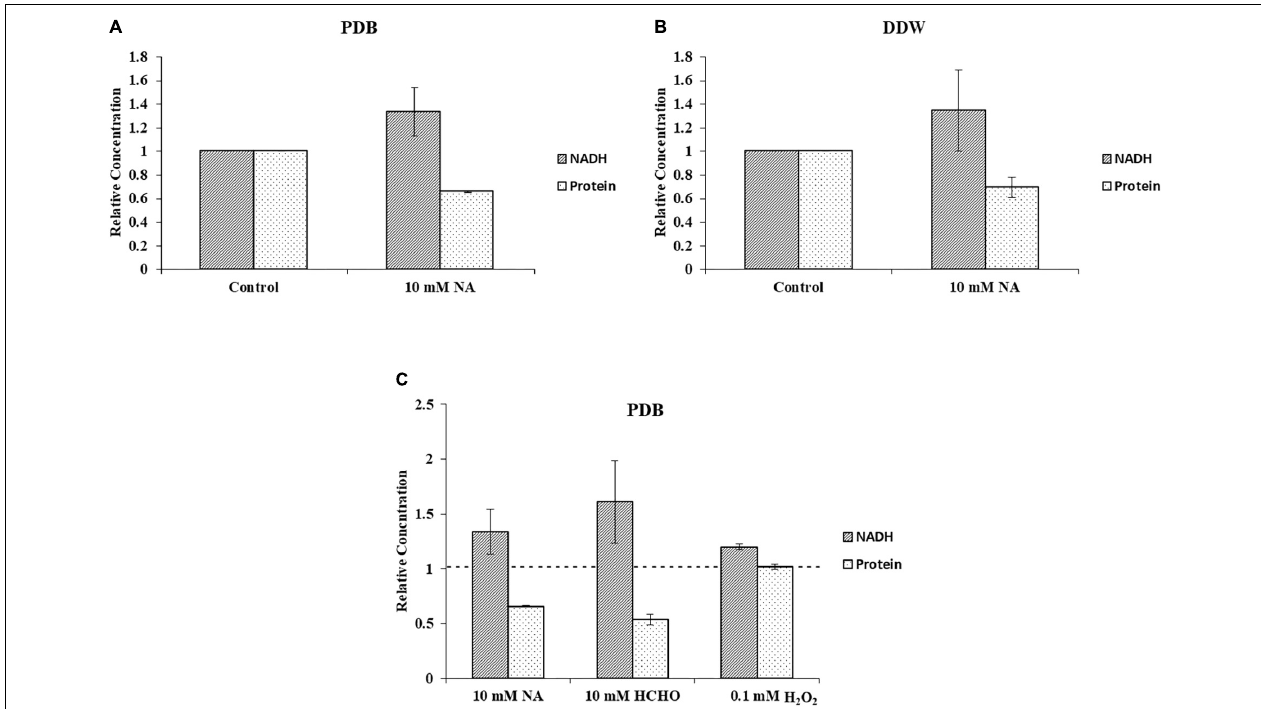
FIGURE 9 | NA increases level of NADH and decreases F. oxysporum biomass. (A) Inverse correlation between NADH and total protein in cultures of F. oxysporum grown in PDB with 10 mM NA. (B) Inverse correlation between NADH and total protein in cultures of F. oxysporum grown in DDW with 10 mM NA. (C) Relation of NADH levels and cellular protein content of F. oxysporum grown in PDB with 10 mM NA, 10 mM HCHO, or 0.1 mM H 2 O 2 . Vertical bars represent relative concentrations of NADH and protein with respect to control as reference. Dotted line represents untreated control. Values are mean ± SD. Vertical lines represent standard error bars.